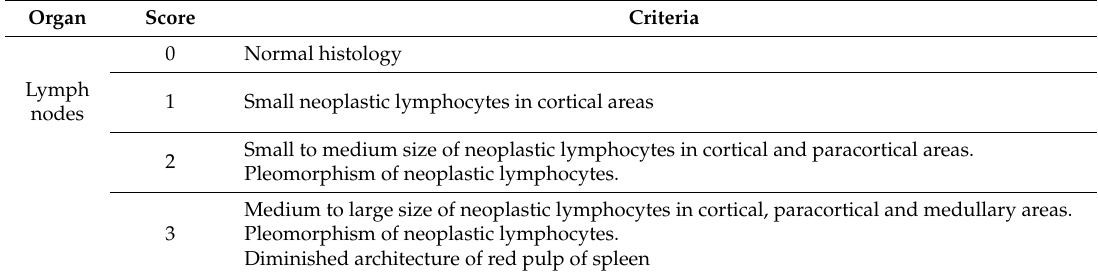
Table 7. Histopathological lesion scoring in the lymph nodes of leukaemia bearing mice. Organ Score